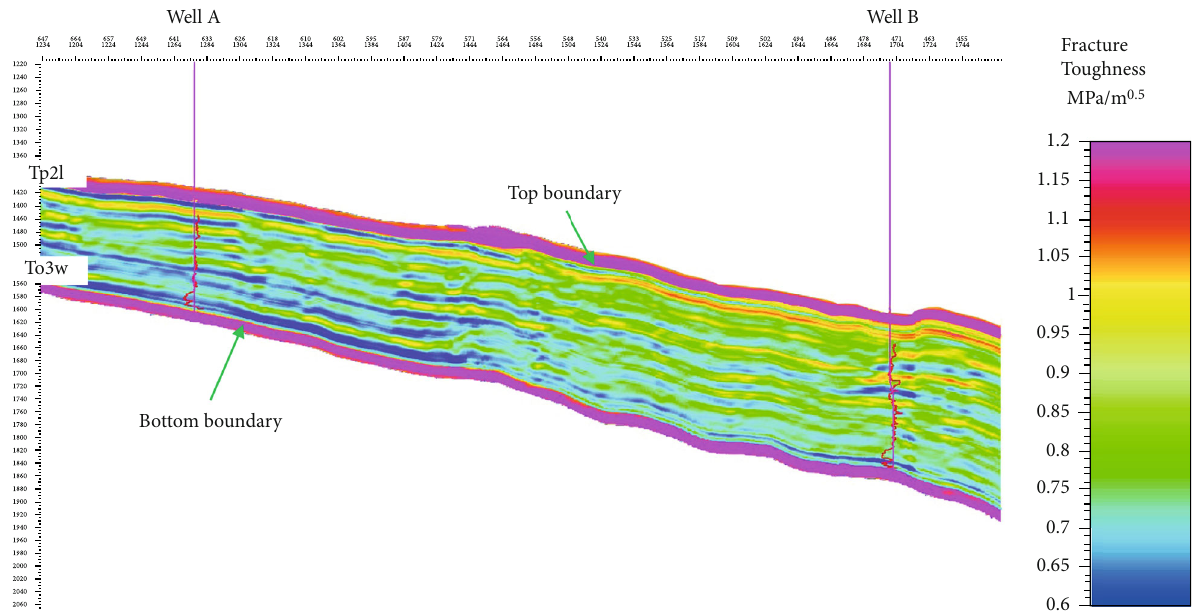
Figure 13: The pro fi le of the fracture toughness values of the Wufeng-Longmaxi formation across Well A to Well